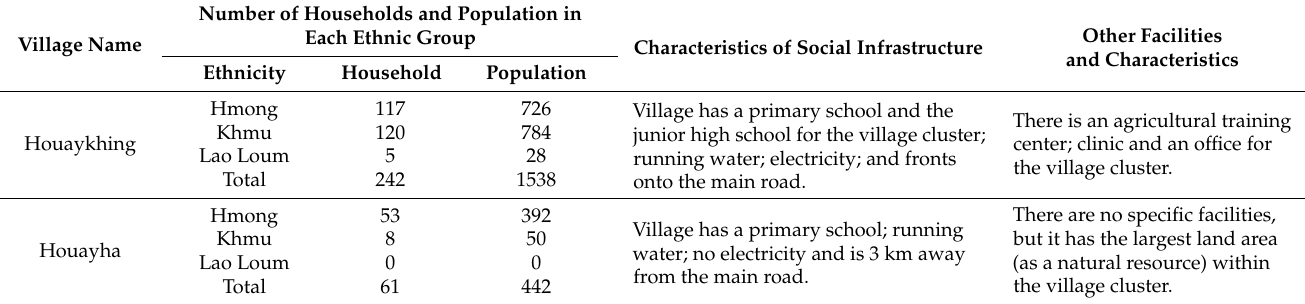
Table 1. General information about the villages of Houaykhing and Houayha in 2019.